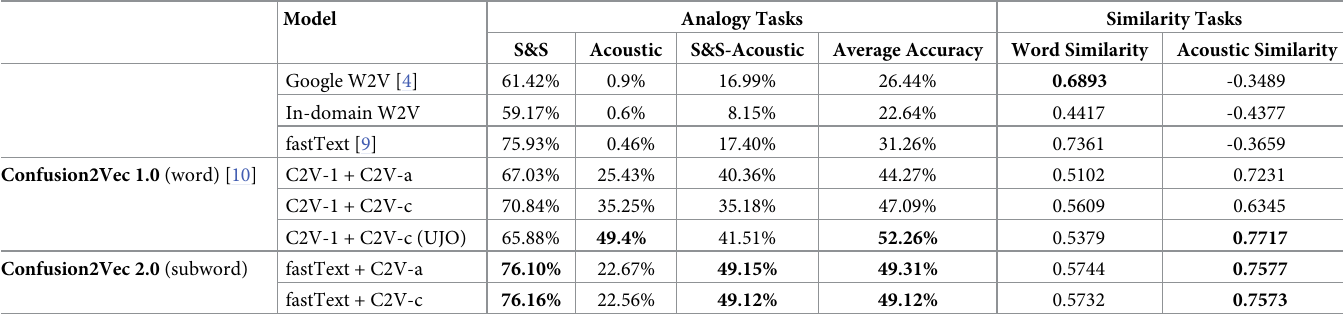
Table 2. Results: Concatenated